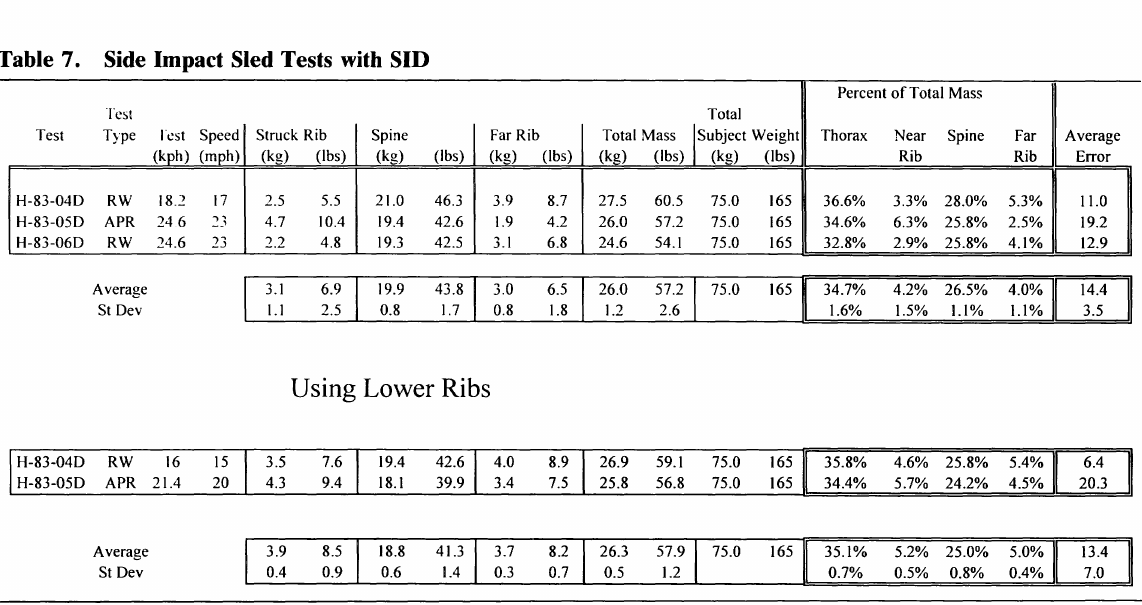
Table 7. Side Impact Sled Tests with